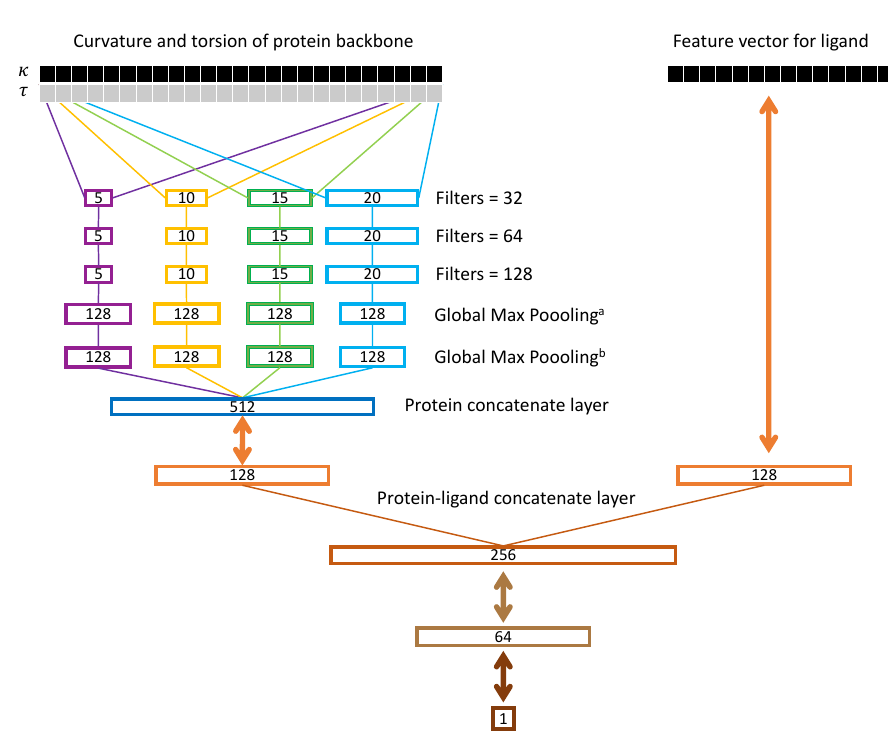
Figure 2. SSnet model. The curvature and torsion pattern of a protein backbone is fed through multiple convolution networks with varying window sizes as branch convolution. Each branch further goes through more convolution with same window size (red, orange, green, and light blue boxes). A global max pooling layer is implemented to get the protein vector. The ligand vector is directly fed to the network. Each double array line implies a fully connected dense layer. The number inside a box represents the dimension of the corresponding vector. In the case of GNN, the ligand vector is replaced by a graph neural network as implemented by Tsubaki et al.